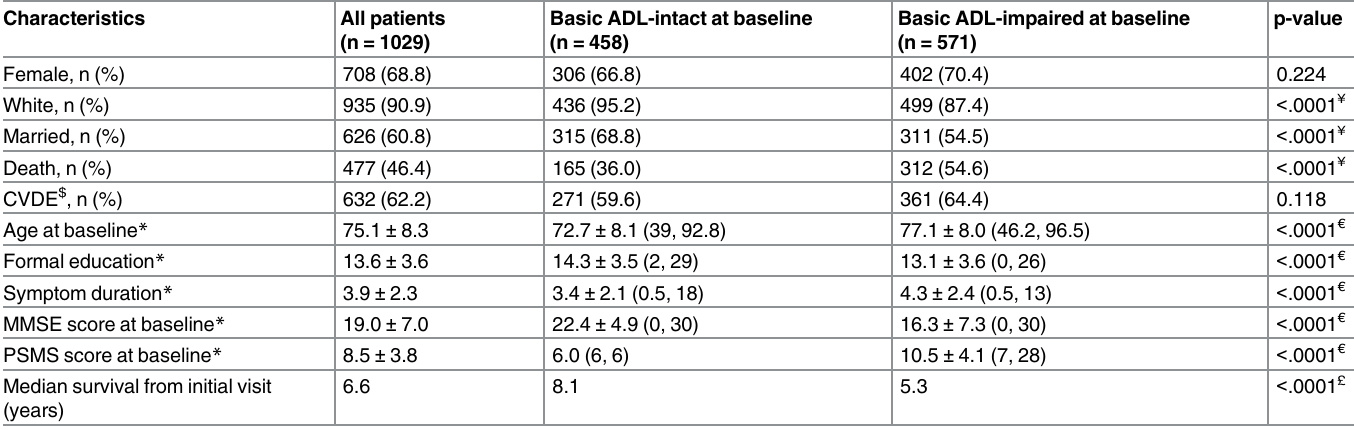
Table 1. Baseline patient characteristics and corresponding comparisons by basic activities of daily living (basic ADL) impairment status.